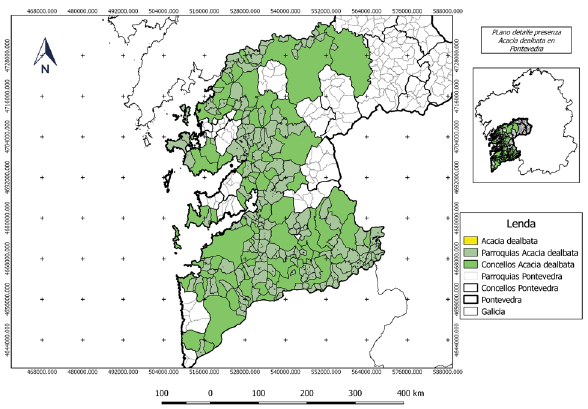
Figure 10 Detected pixels in a area of Acacia overlaid on a